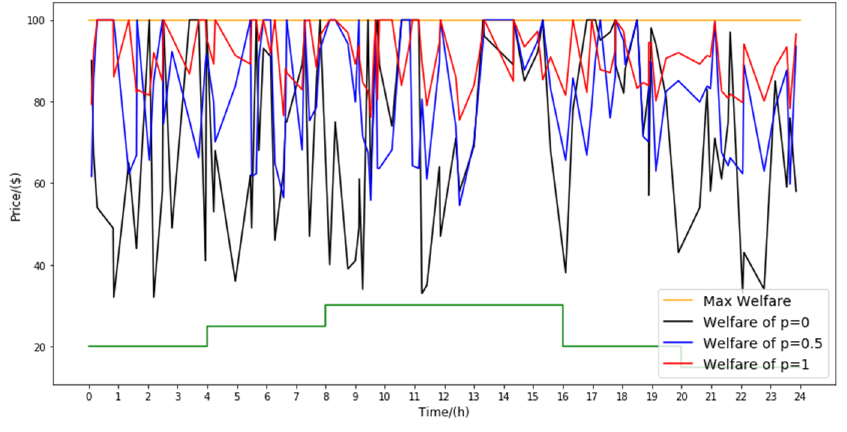
Figure 10. Total welfare after the introduction of external bidders.